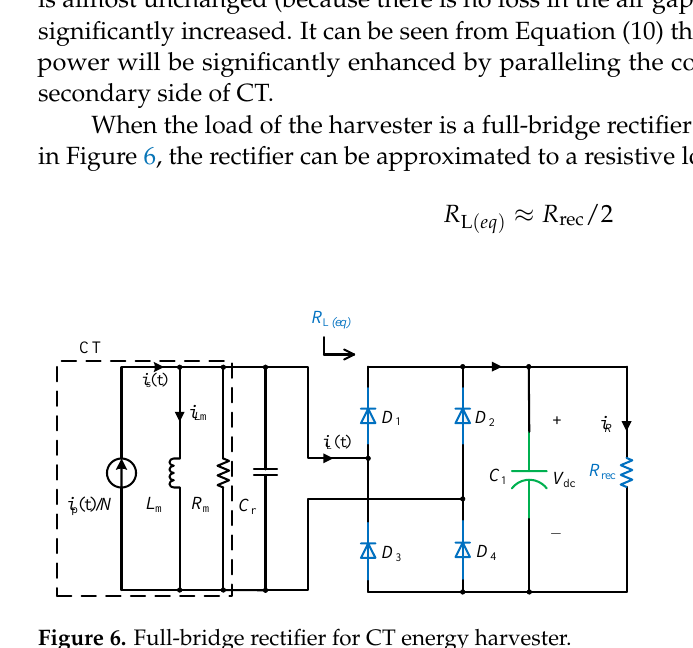
Figure 6. Full-bridge rectifier for CT energy harvester.